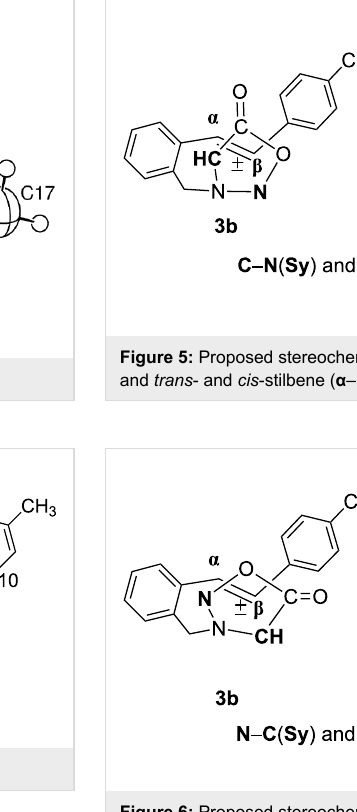
Figure 6: Proposed stereochemical pathway of sydnone ring ( N – CH ) and trans - and cis -stilbene ( α – β